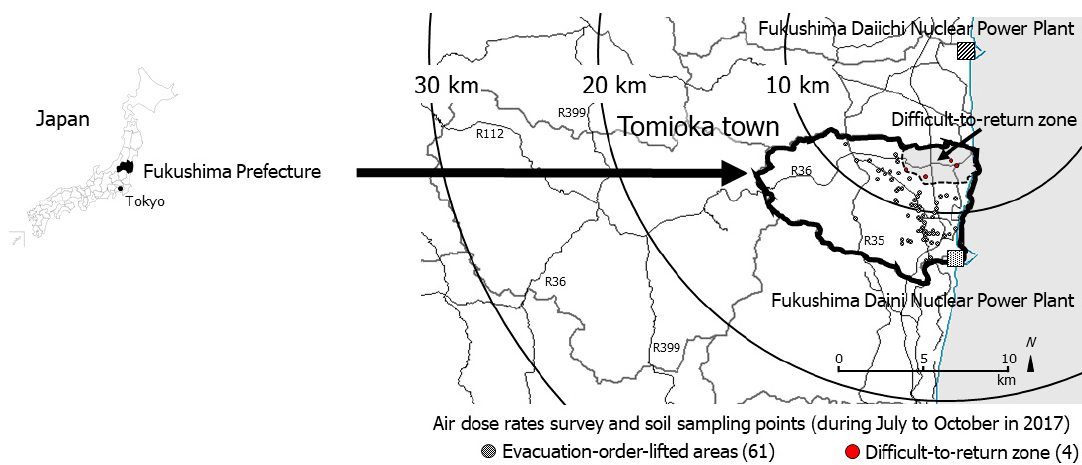
Figure 1. Location of Tomioka town, Fukushima Prefecture.